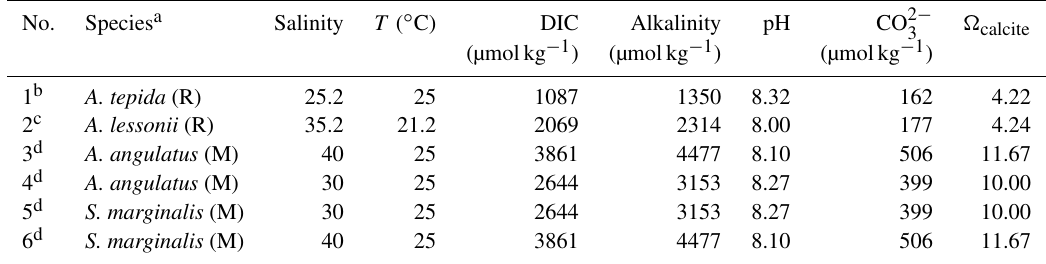
Table 1. The foraminifera specimens studied and the corresponding culture conditions. No. Species a